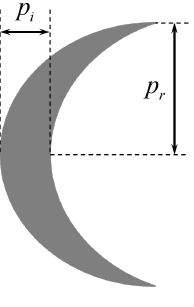
Figure 2. Expected Moon radius ( p